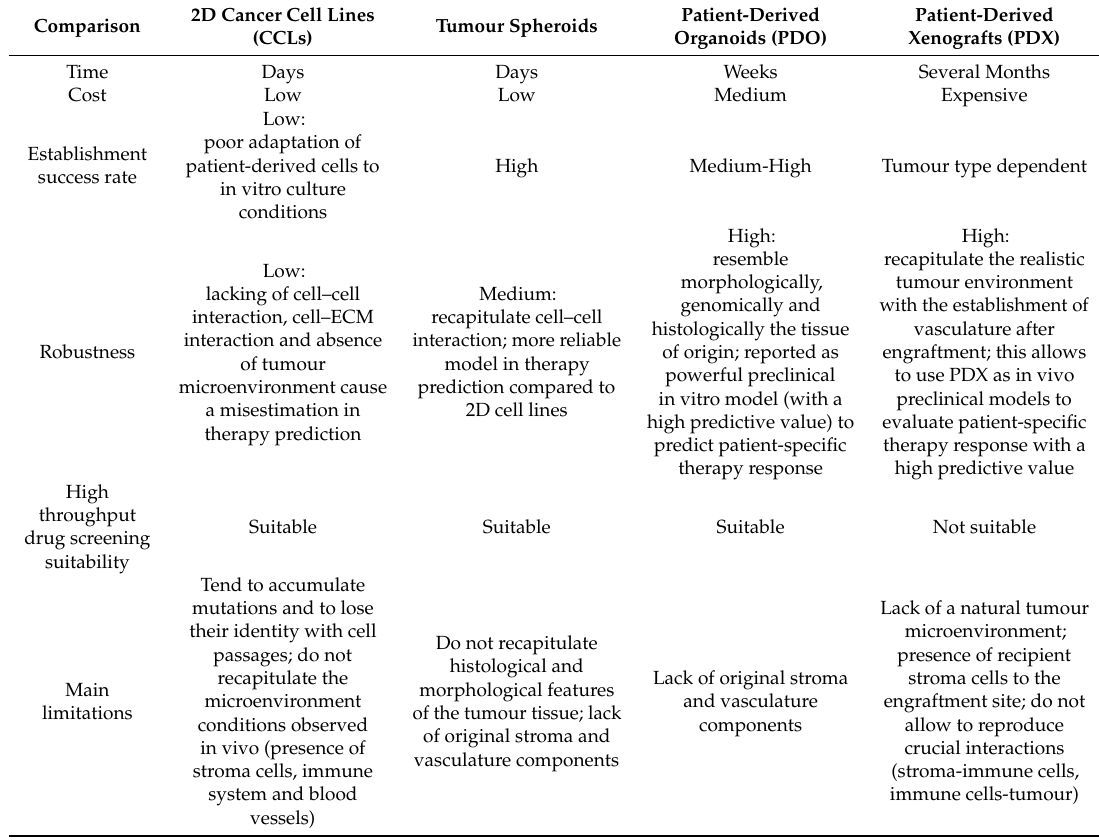
Table 1. Comparison of the main cancer models considering time, cost, establishment success rate, robustness, high throughput suitability and main